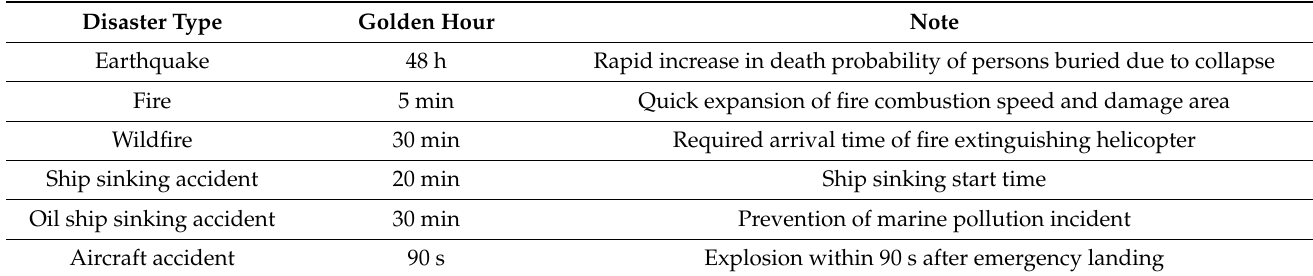
Table 3. Golden hours for some disaster